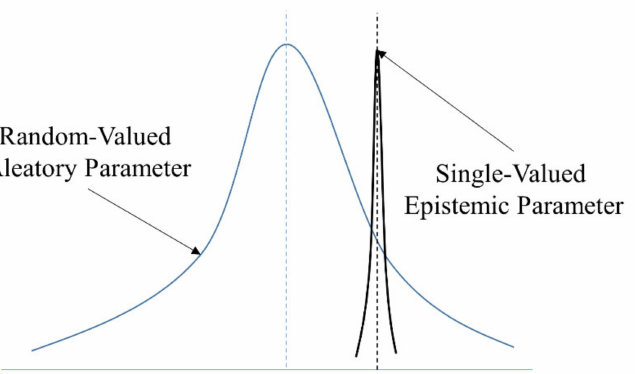
Figure A1. PDF Examples for True Values of Epistemic and Aleatory